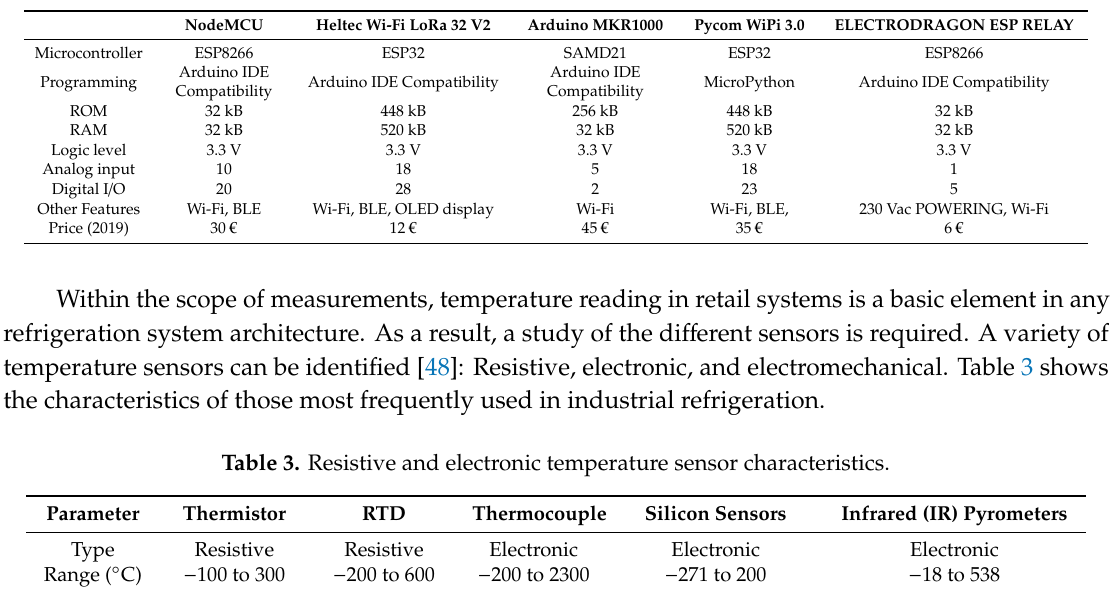
Table 2. Features of the electronic boards considered.